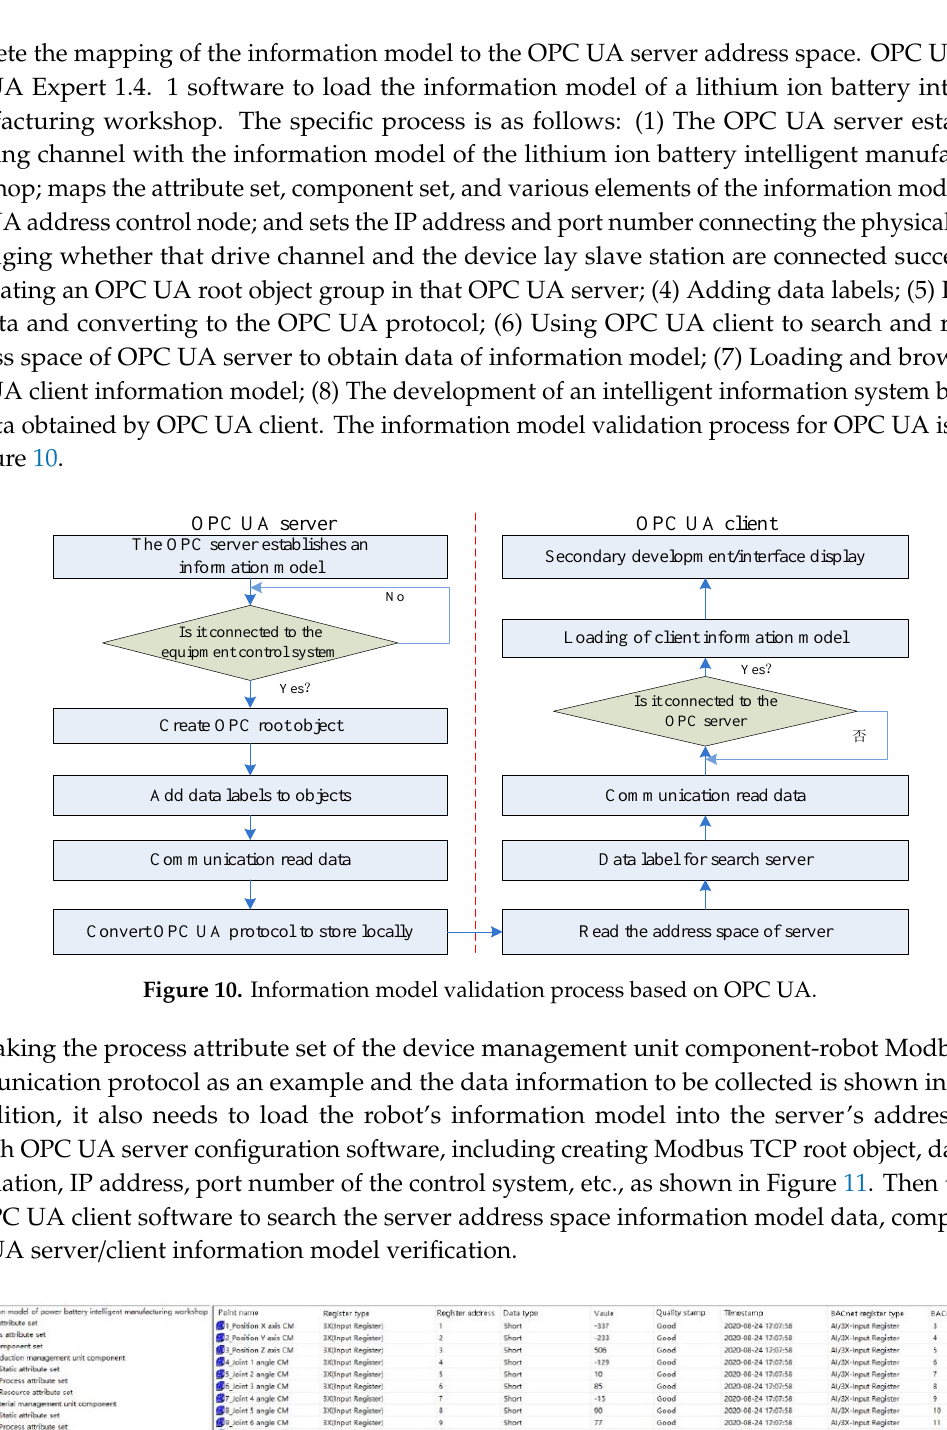
Table 7. Information table of collected robot data (Part).